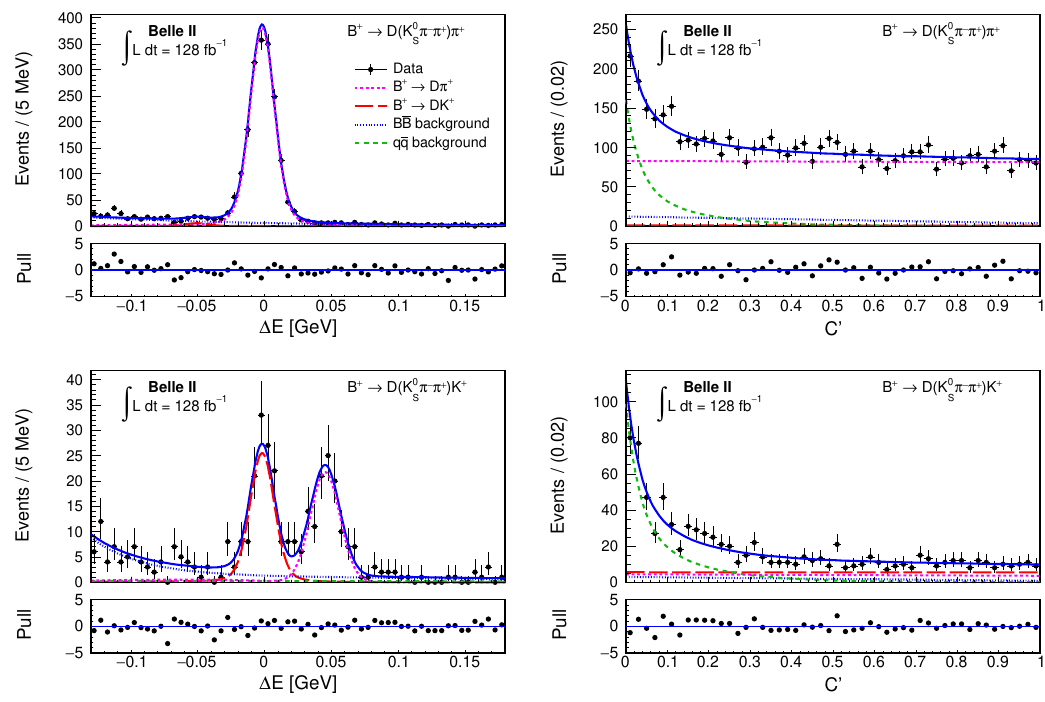
Figure 4 . Distributions of (left) ∆ E and (right) C 0 for (top) B + → D ( K 0 B + → D ( K 0 π − π + ) K + candidates restricted to the signal-enhanced region in the Belle II data set S with fit projections overlaid. The black points with error bars represent data and the solid blue curve is the total fit. The large-dotted magenta, long-dashed red, small-dotted blue and short-dashed green curves represent B + → Dπ + , B + → DK + , q ¯ q and combinatorial B ¯ B background components, respectively. Differences between the fit function and data normalised by the uncertainty in data (pull) are shown under each